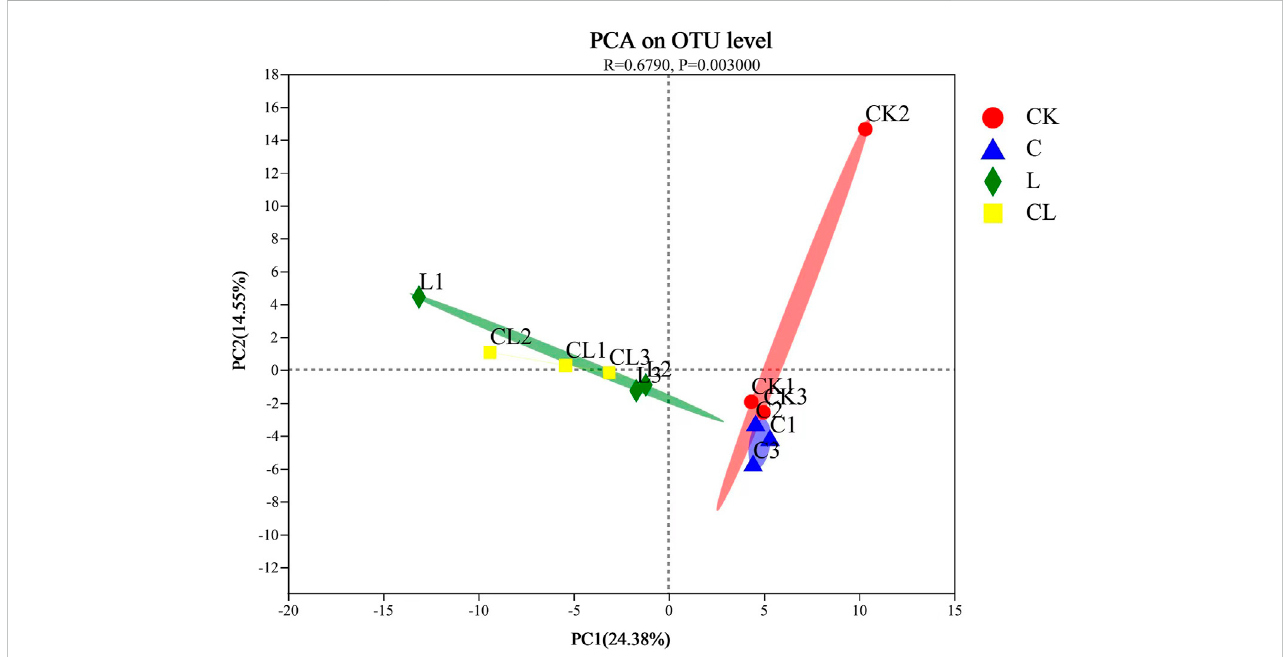
FIGURE 2 Principal coordinate anaysis (PCoA) of microbial community in Caragana korshinskii silage with different